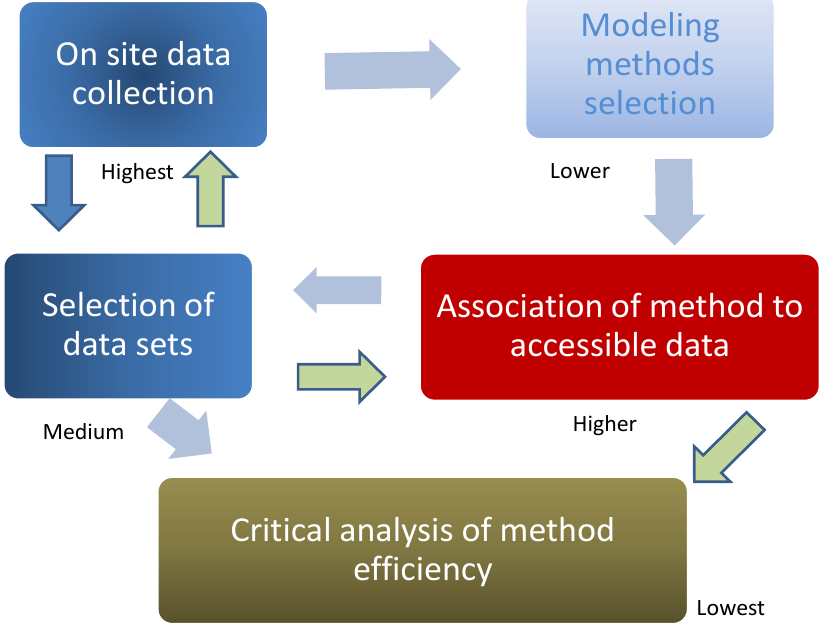
Figure 1. Methodological Flow Chart of different tasks and relative intellectual investment and time-consuming visualization.